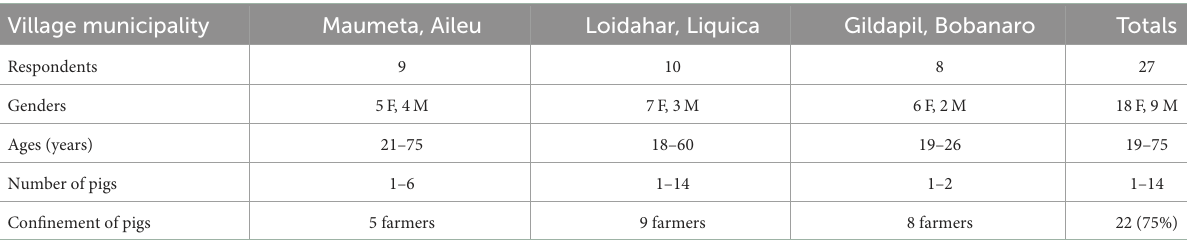
TABLE 6 Gender, age, and pig ownership of 27 farmers that participated in the evaluation